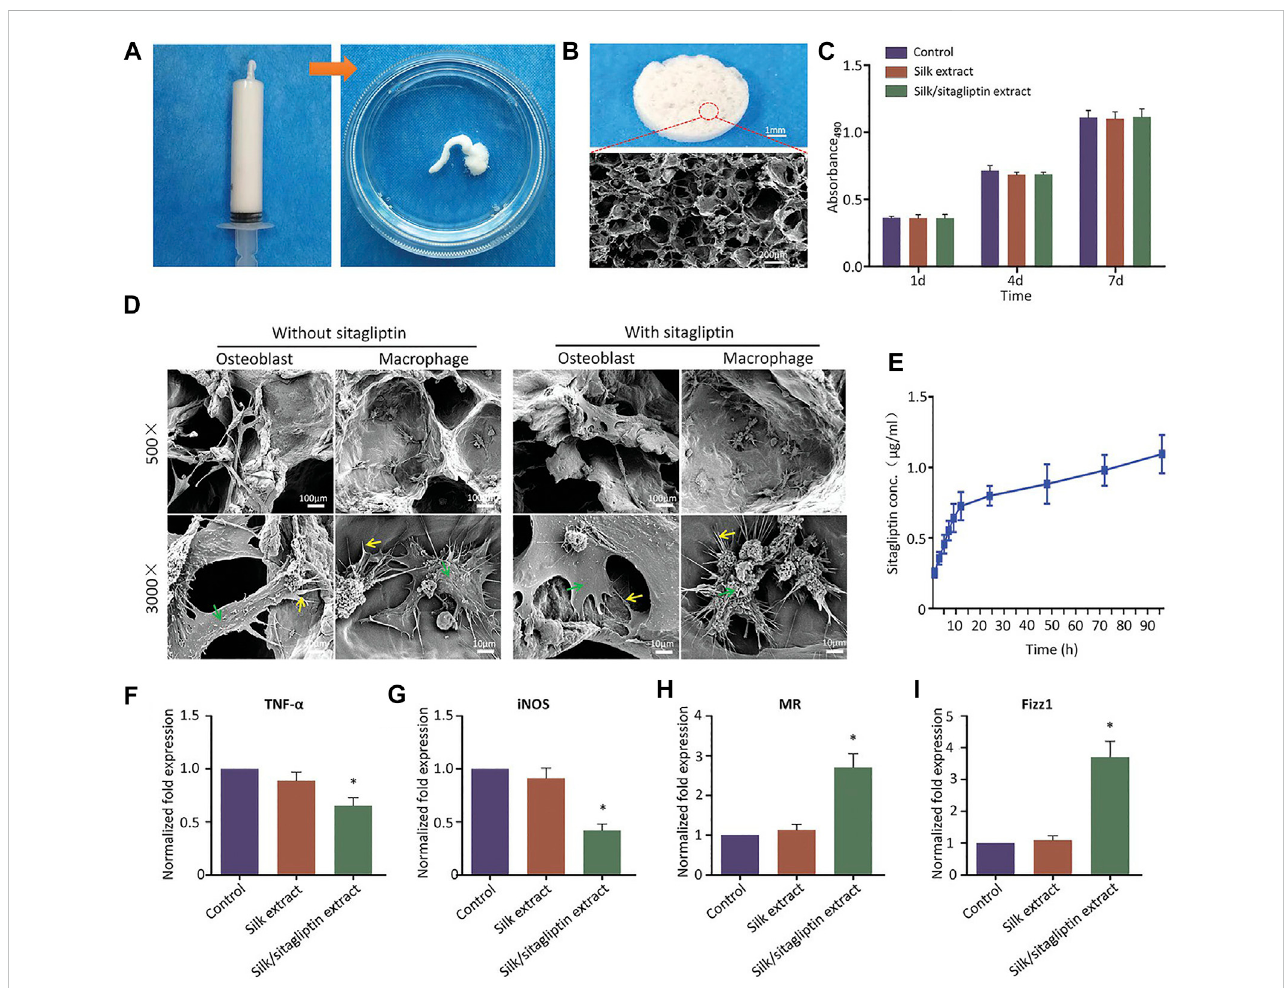
FIGURE 5 Injectablecharacterizationofthescaffoldsystem (A) .MicrostructureofthescaffoldunderSEM (B) .Theproliferationofmousecellsatday1,7,and14 (C) . The attachment of macrophages or osteoblasts to scaffolds under SEM (D) . Drug release curve in the scaffold system (E) . The expression of M1-related biomarkers after 24 h (F, G) . The expression of M2-related markers after 24 h (H, I) . * p < 0.05 comapered with control group. Reproduced with permission from (Xiang et al.,